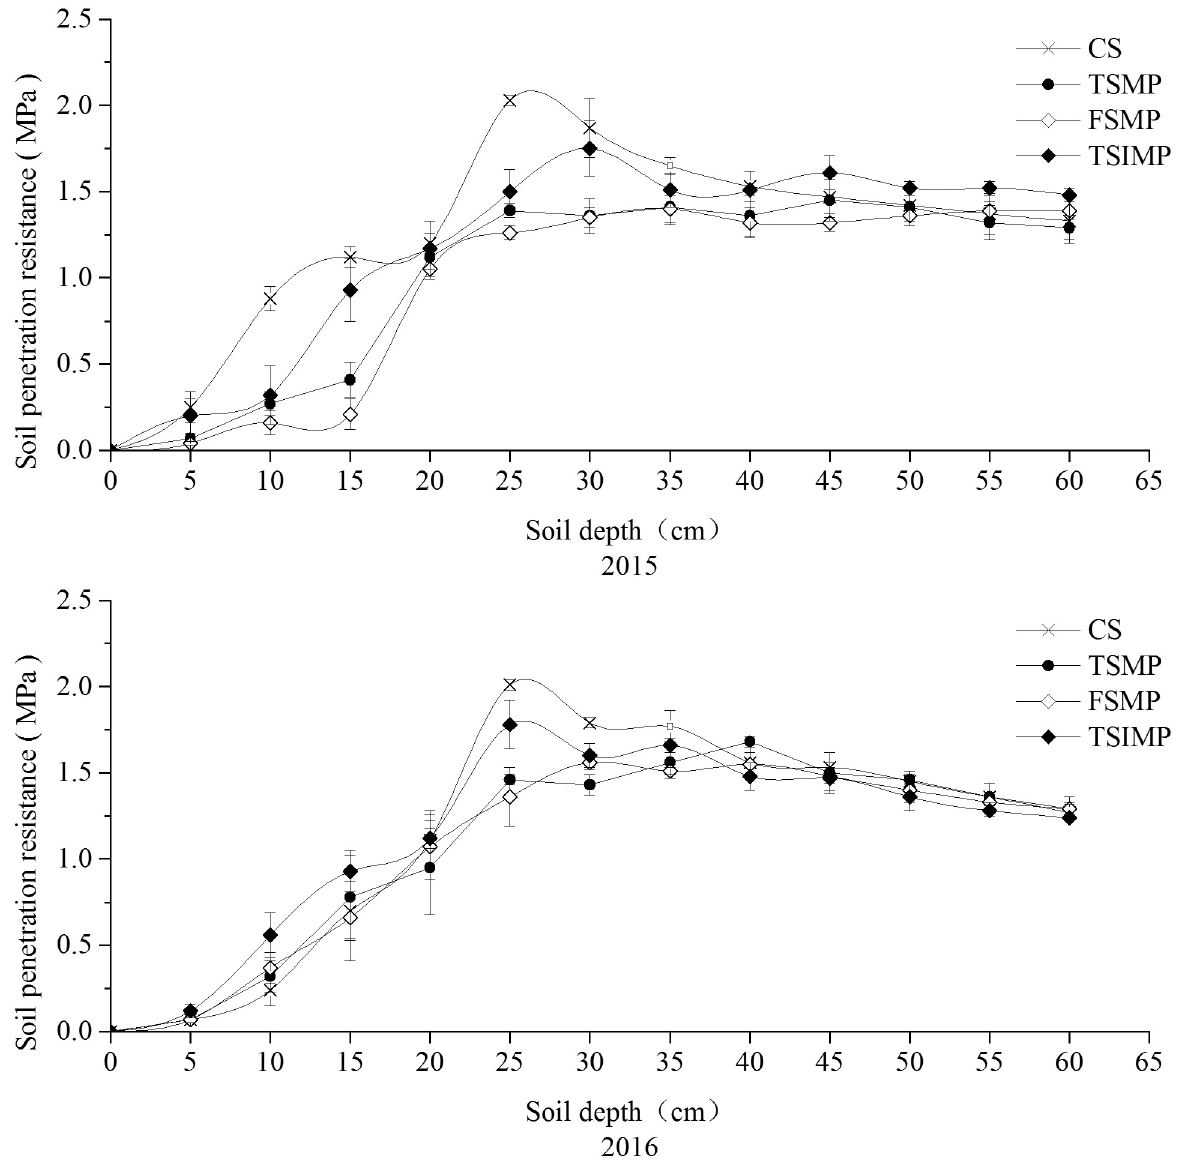
Fig 4. Effects of soil mixing on the soil penetration resistance of Albic soil. Bars represent standard errors (n = 3).